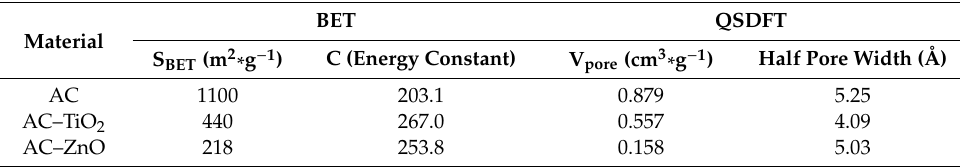
Table 1. BET and Quenched Solid Density Functional Theory (QSDFT) parameters.